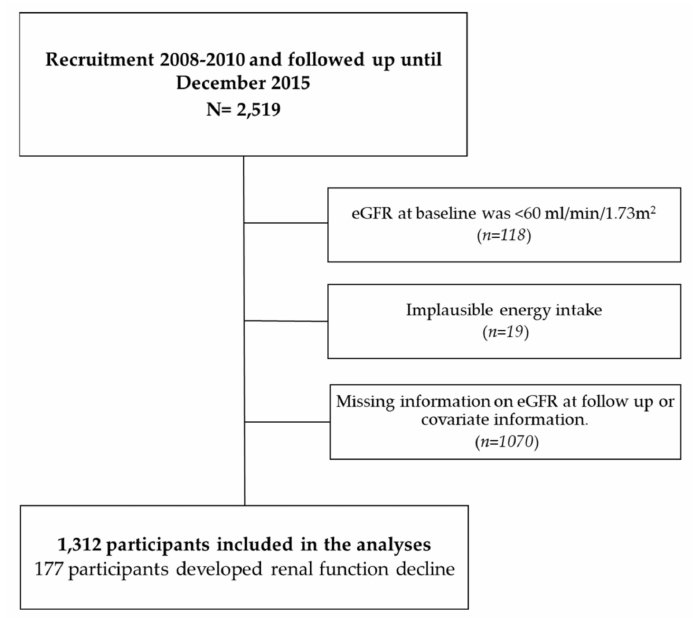
Figure 1. Participants’